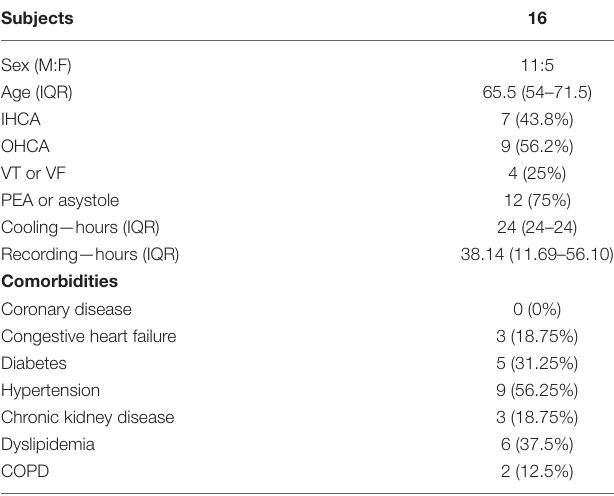
Frontiers in Medicine |